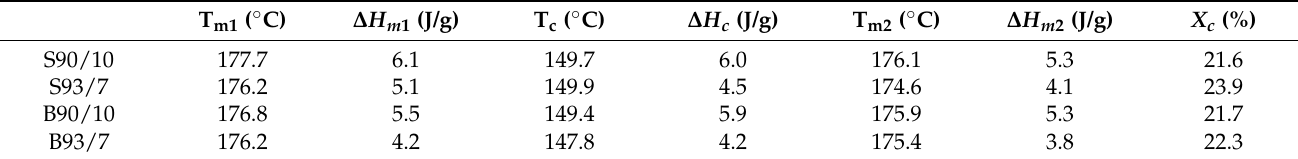
cycle; and the calculated degree of crystallinity, X c .